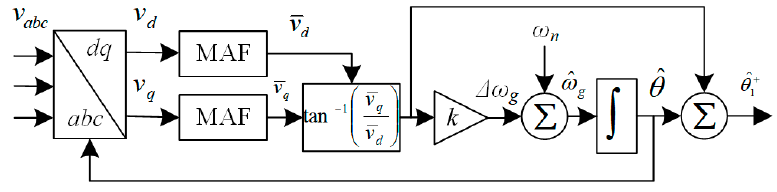
Figure 10. Block diagram of quasi ‐ type ‐ 1 (QT1) ‐ PLL.